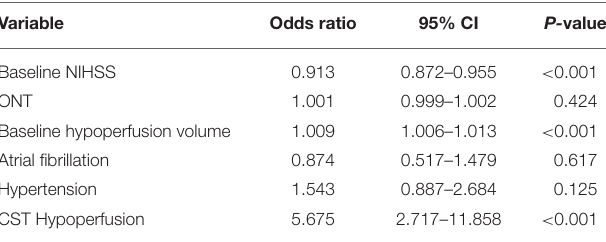
TABLE 3 | Multivariable analysis for unexplained early neurological